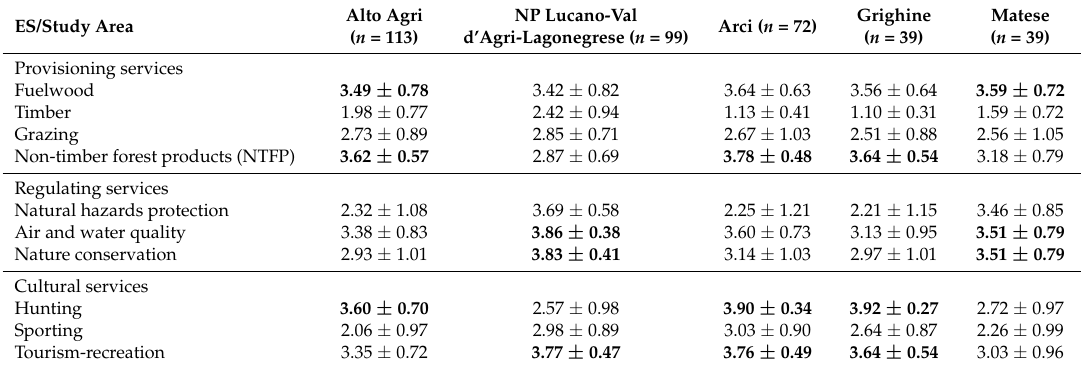
Table 1. Stakeholders’ preferences for ten ES by study area (mean value).